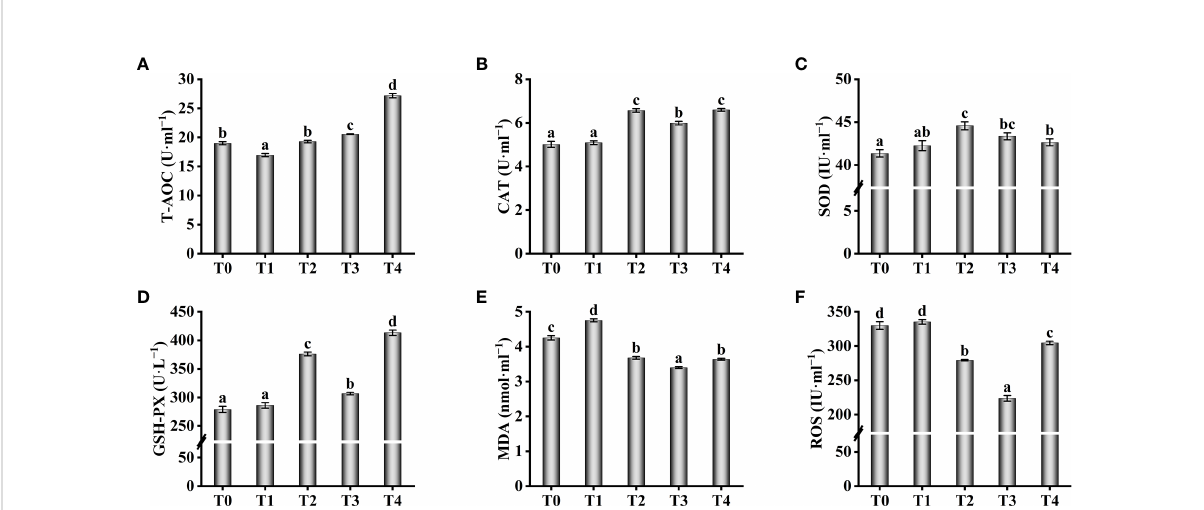
FIGURE 4 Effect of antioxidant capability such as T-AOC (A) , CAT (B) , SOD (C) , GSH-PX (D) , MDA (E) and ROS (F) in the serum of T. ovatus fed diets with different dose taurine supplementation after 8 weeks. Mean values (n = 9) within values in the picture above with different superscripts are signi fi cantly different ( P < 0.05).